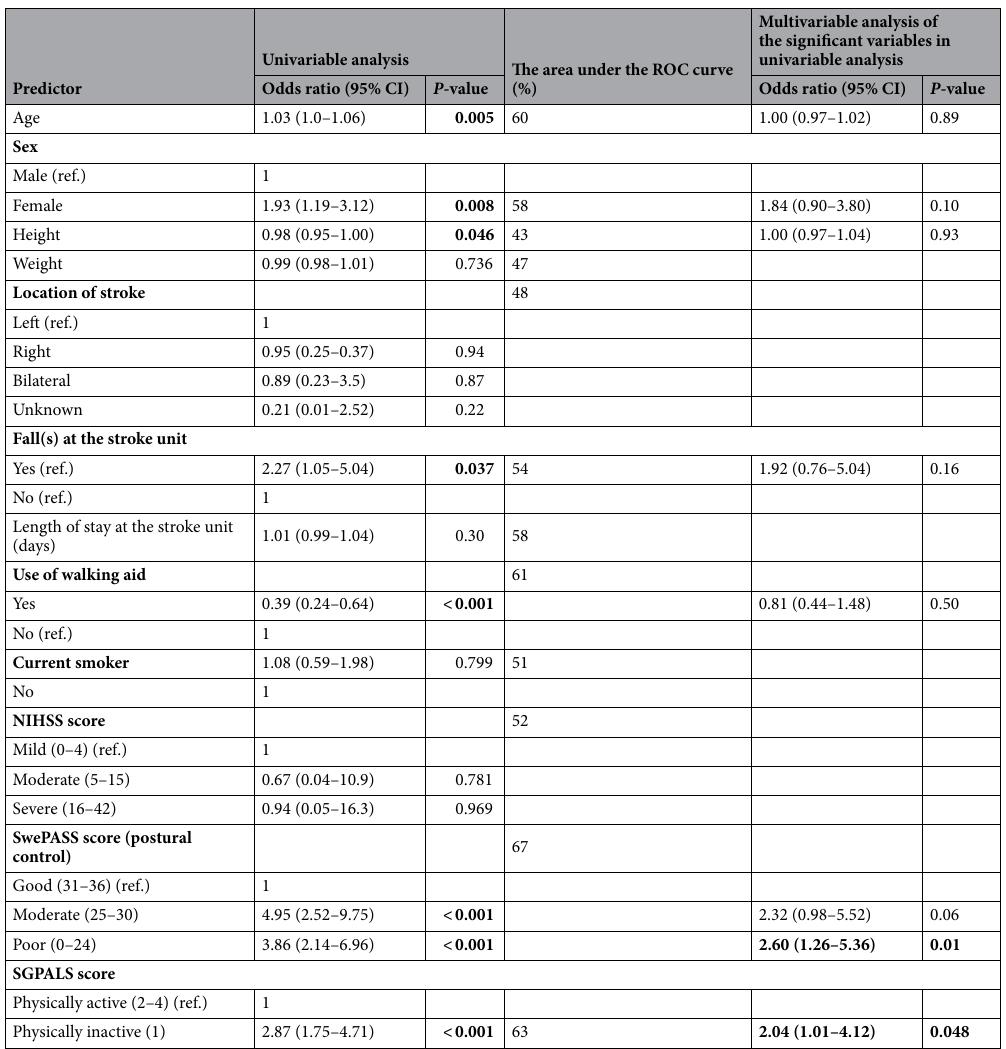
Table 2. Univariable and multivariable analyses for prediction of fear of falling 6 months after stroke. CI, confidence interval; ROC, Receiver Operating Characteristic; SwePASS, The Modified Version of the Postural Assessment Scale for Stroke Patients; SGPALS, the Saltin-Grimby Physical Activity Level Scale. Variables with p-values less than 0.1 and 0.05 were considered significant for the univariable and multivariable analyses respectively, and are presented in bold. For the multivariable regression model, the p -value of the Hosmer and Lemeshow test was 0.31, the Cox and Snell R 2 was 0.14 and the Nagelkerke R 2 was 0.19. Included in the multivariable analysis, n =